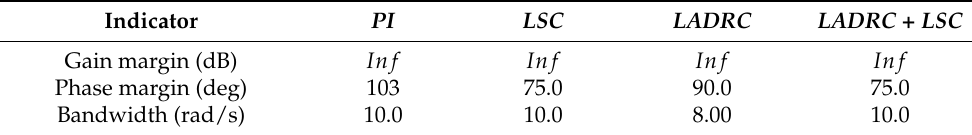
Table 1. Non-linear models performance metrics.